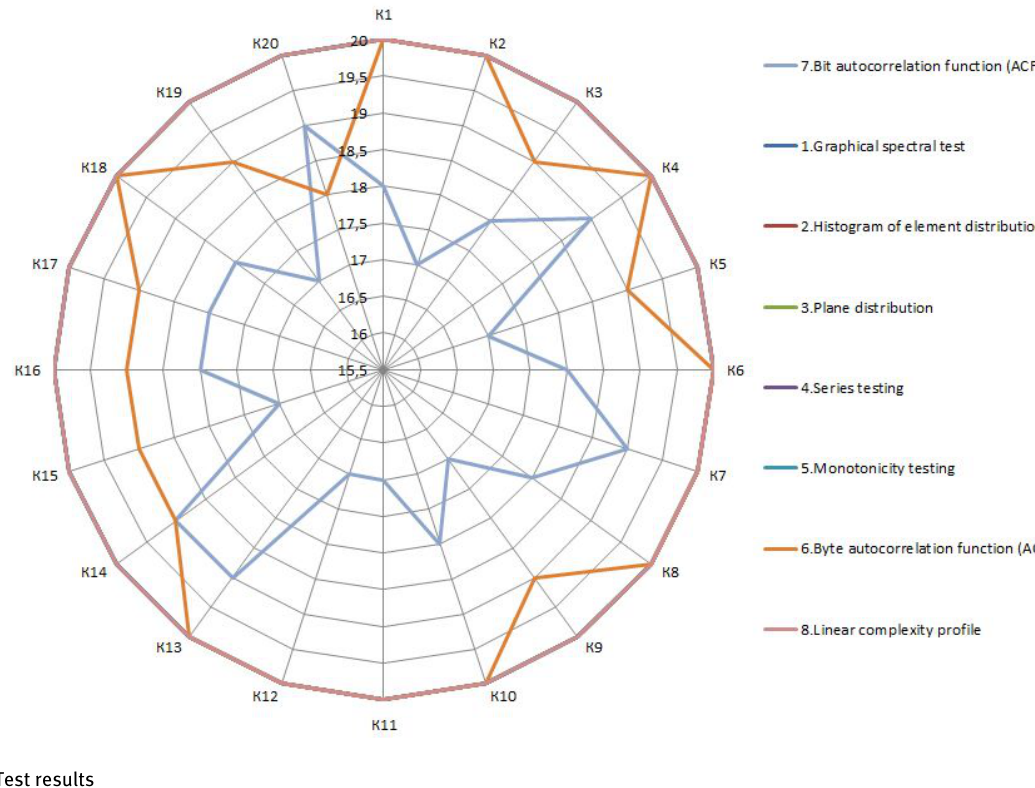
Figure 6: Test results